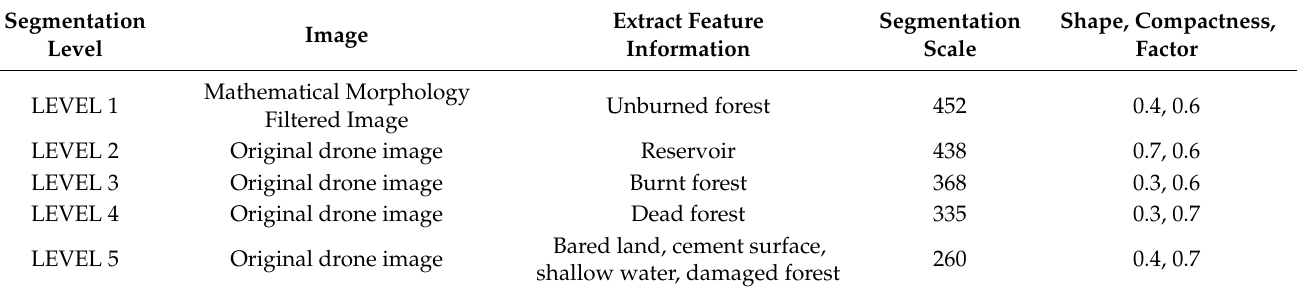
Table 2. Classification levels of different